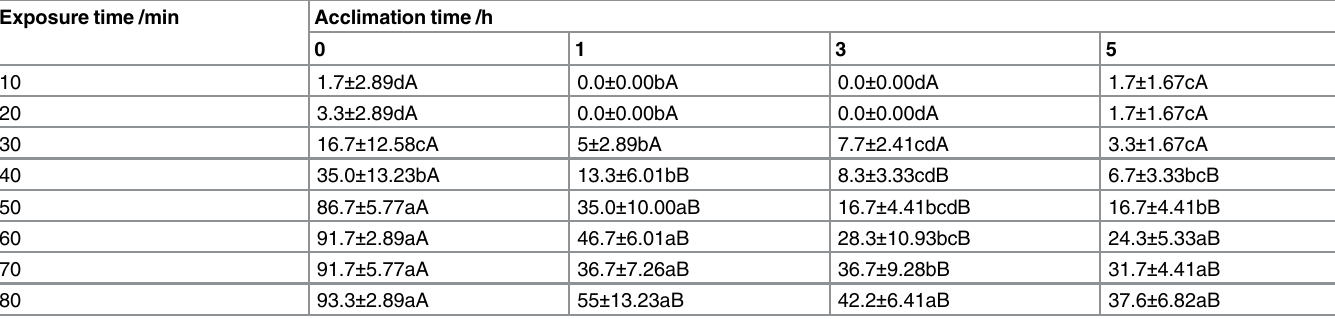
Table 3. The effect of acclimation to sublethal high temperature on mortality (%) of S . zeamais exposed to 47°C. Exposure time /min